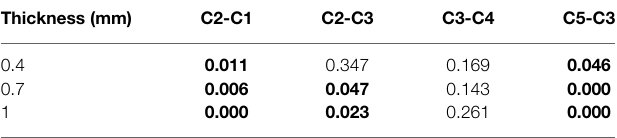
TABLE 11 | The p -values of pair t -test for glasses with different thicknesses .